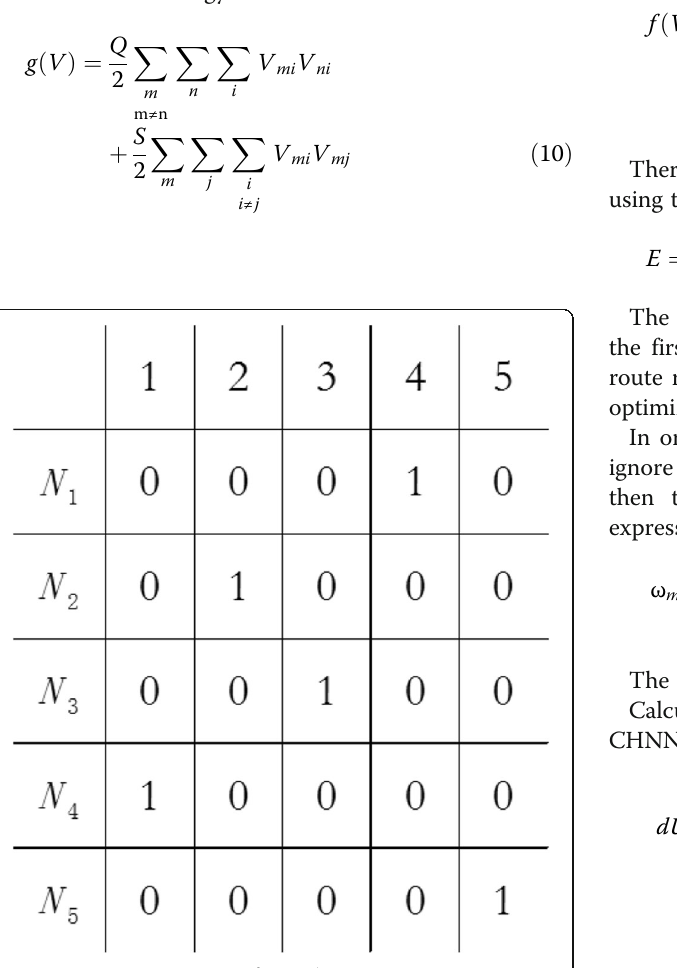
Fig. 2 Use matrix to represent five nodes FANET routing. Use matrix to represent five nodes FANET routing; the only route is shown: Source - > N4 - > N2 - > N3 - > N1 - > N5 - >